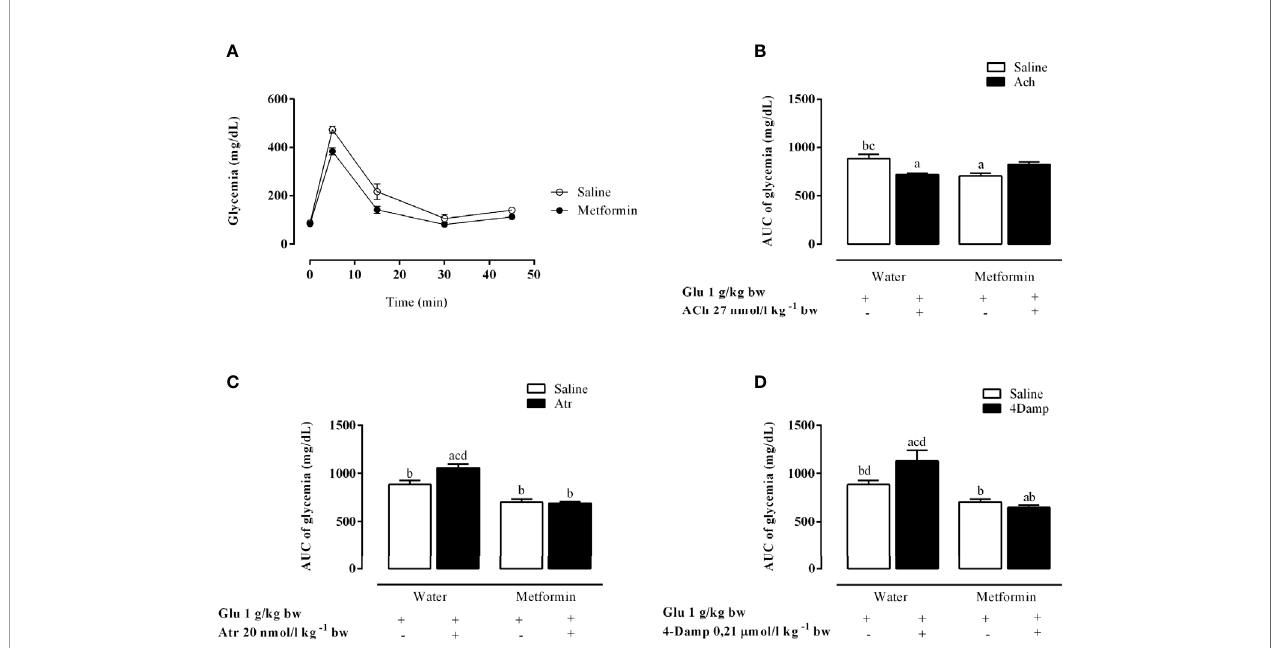
FIGURE 1 | Effects of muscarinic receptor agonist and antagonists on glycaemia throughout the intravenous glucose tolerance test (ivGTT). (A) Effect of metformin treatment on glycaemia during the ivGTT. (B – D) show the glucose load-induced area under the glycaemia curve during IVGTT after pretreatment with Ach, Atr and 4-DAMP, respectively. The bars represent the mean ± SEM from 8 – 12 rats for each treatment, and letters over the bars represent the statistically signi fi cant differences using a one-way ANOVA (p <0.0003 and p <0.0001) among the groups.